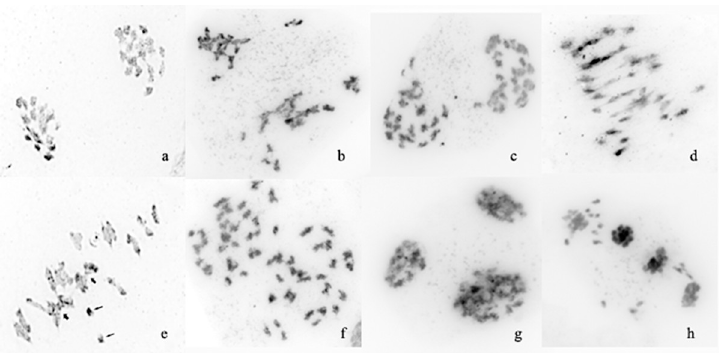
Fig 4. Meiosis in maternal pollen cells in B . napus cv. Vikros and mutant plants. (a) A-I, 19 II ; (b) several chromosomes are localized outside the metaphase plate; (c) A-I, chromosome lagging; (d) A-I, chromosomal bridges; (e) M-I, 14 II +2 IV (short arrows)+2 I (long arrows); (f) A-I, chaotic disjunction and chromosome lagging; (g) three-polar configuration with chromatin agglutination; (h) asynchronous division within one meiocyte.